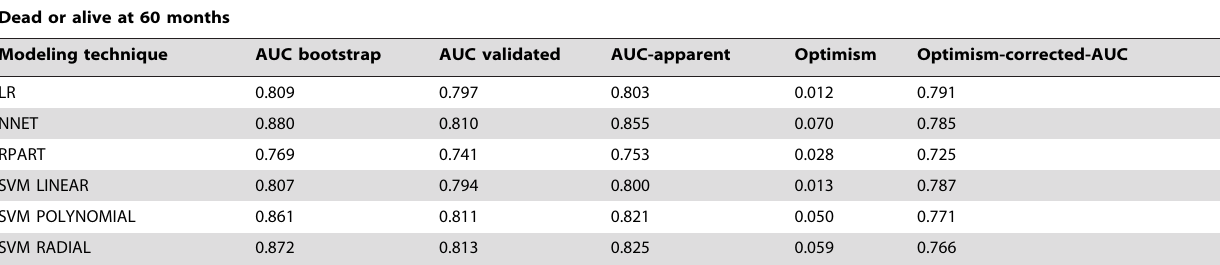
Dead or alive at 60 months